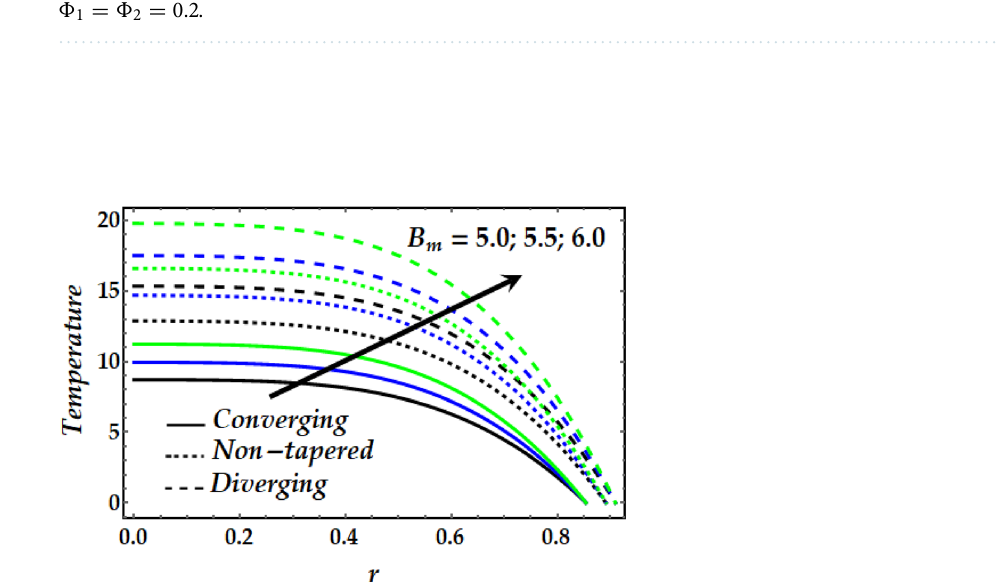
Figure 10. Behavior of streamlines against distinct values of ( a ) (cid:31) 1 = (cid:31) 2 = 0, ( b ) (cid:31) 1 = (cid:31) 2 = 0.1 , ( c ) (cid:31)